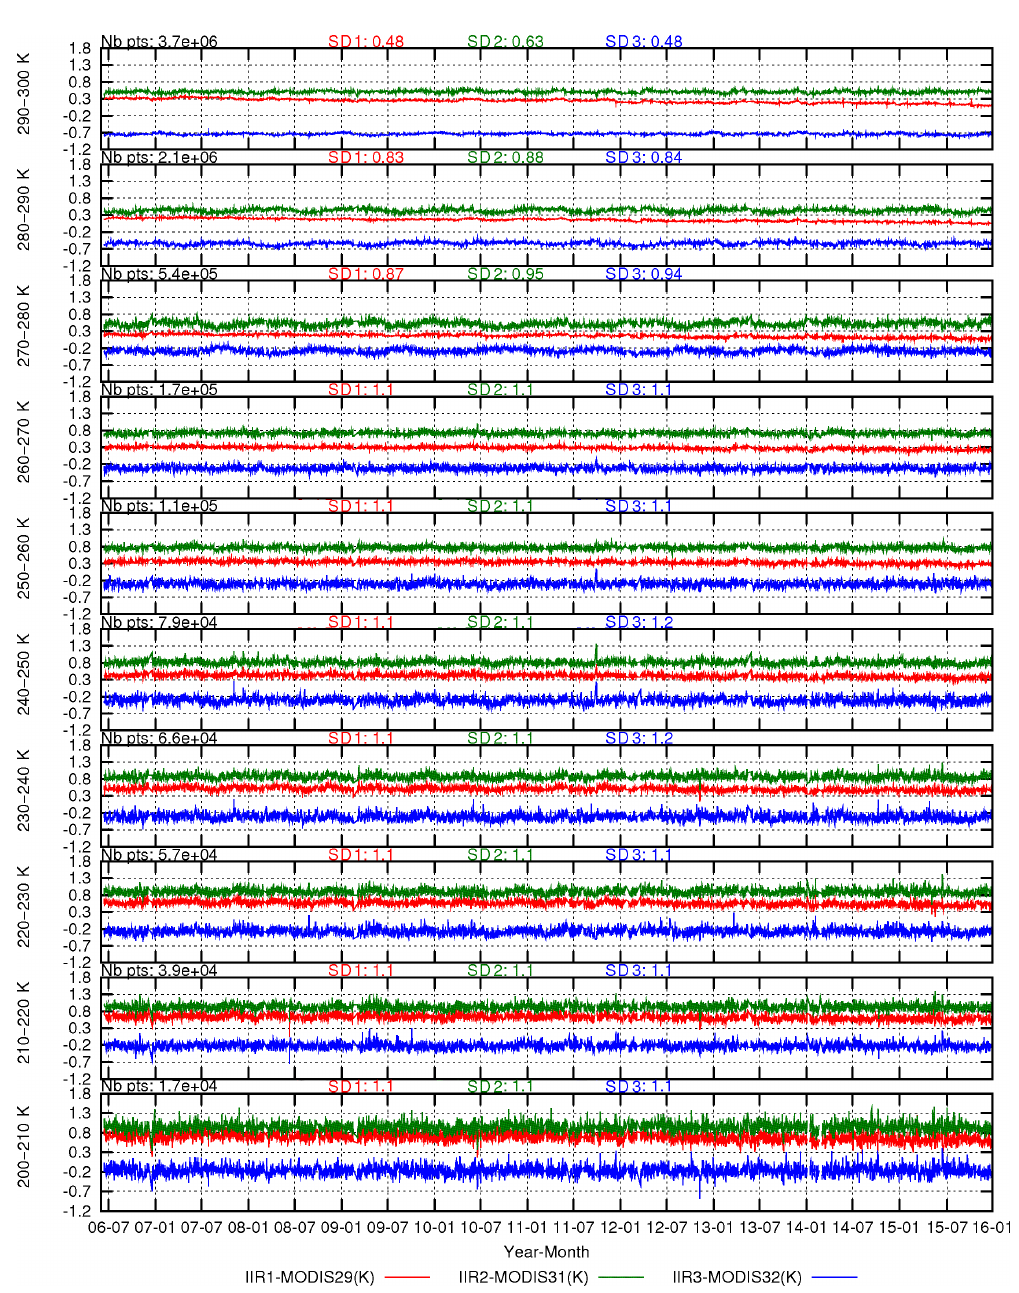
Figure 3. Time series ( x axis: year-month) of daily averaged (day and night combined) IIR–MODIS brightness temperature differences ( y -axis units: Kelvin) for the three pairs of companion channels (red: IIR1–MODIS29, green: IIR2–MODIS31, blue: IIR3–MODIS32) over ocean in the tropics at 30 ◦ S–30 ◦ N. Each panel is for a given range in brightness temperature from 290–300K (top) down to 200–210K (bottom). Added at the top of each panel are the mean number of points per day (Nb pts) and the mean standard deviation per day for each of the three pairs (see Table